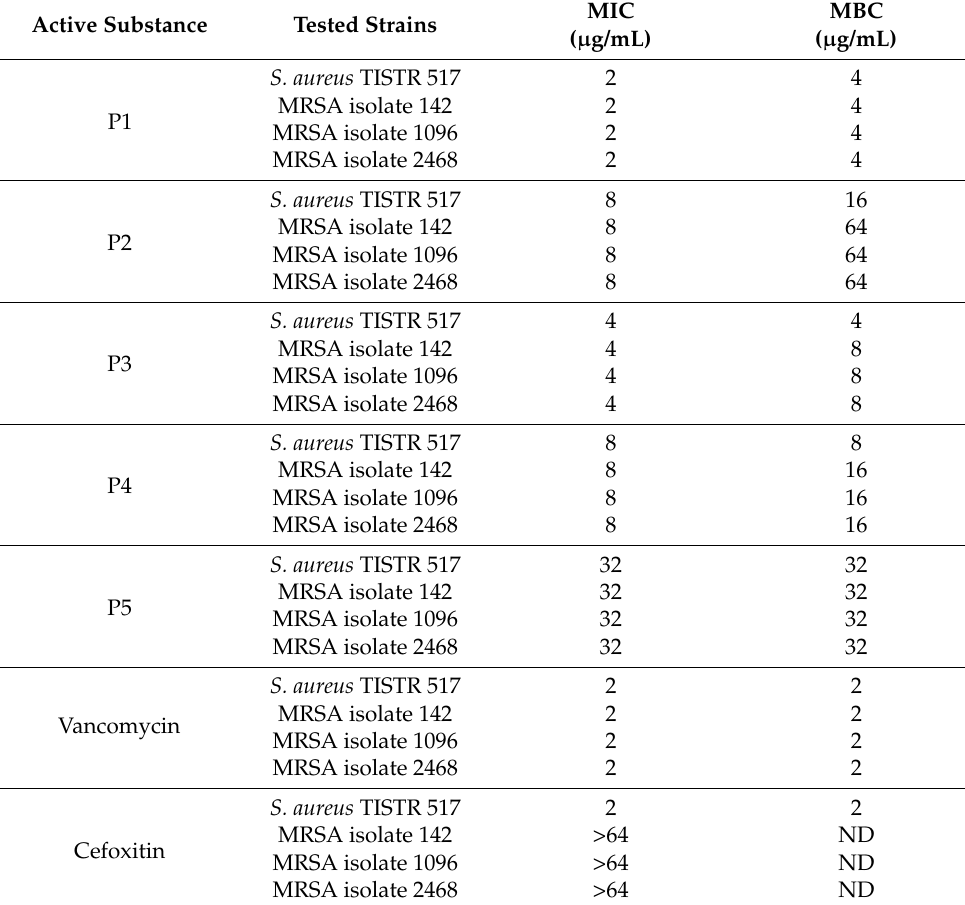
Table 2. The MIC and MBC values of the purified substances from SPR-20. The active substances from RPC were used to determine the antimicrobial activity. The standard antibiotics (vancomycin and cefoxitin) were used as the positive